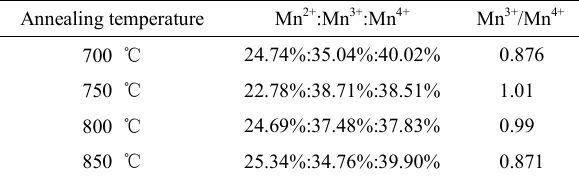
Table 2 Ratio of Mn 2+ :Mn 3+ :Mn 4+ and Mn 3+ /Mn 4+ of